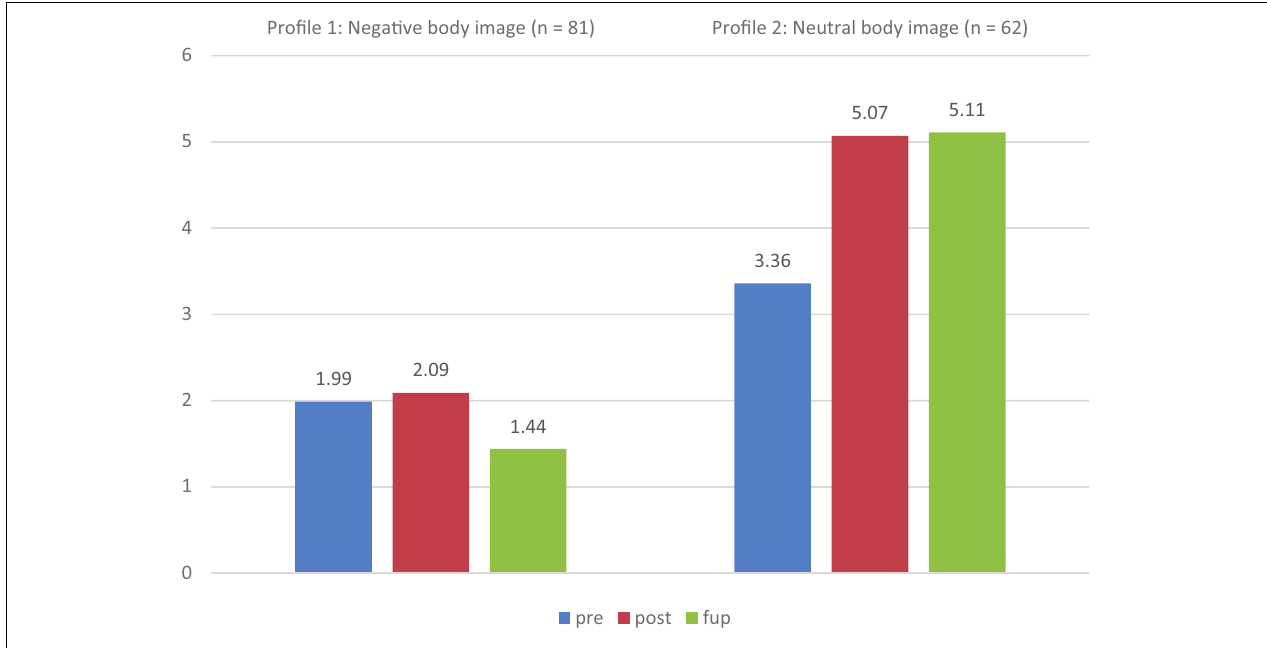
pre post fup FIGURE 1 | Changes in mean Body Image Assessment (BIA) scores of the two profiles generated by LPA over the three assessment points.